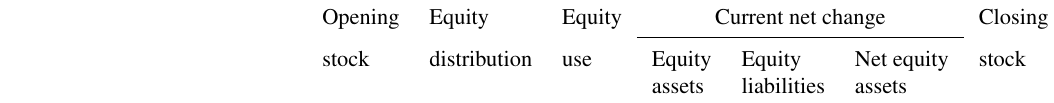
Table 1. Basic statement form of the water resources equity balance sheet.